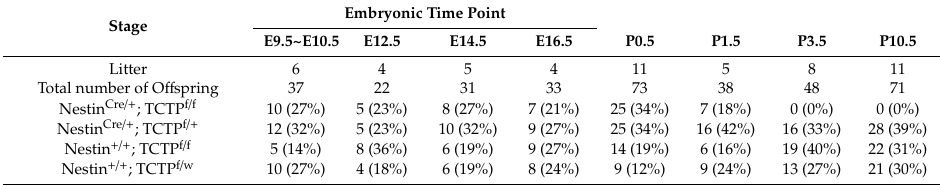
Table 1. Genotype analysis of o ff spring from Nestin Cre /+ ; TCTP f /+ mice crossed with TCTP f / f